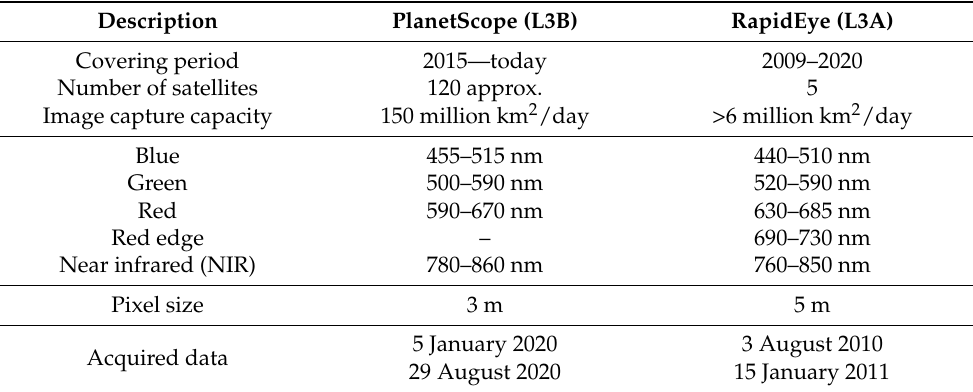
Table 1. PlanetScope and RapidEye properties and data acquired.